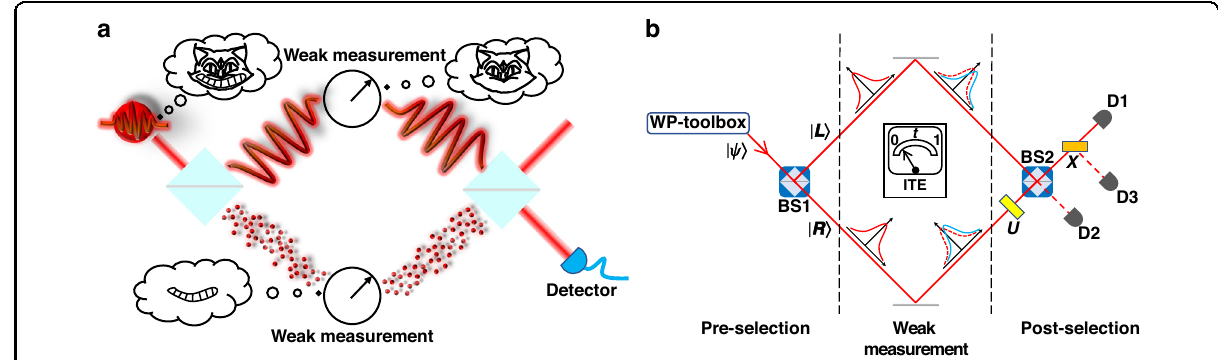
Fig. 1 Schematic for the separation of the wave and particle attributes, inspired by the quantum Cheshire cat concept. a Conceptual diagram. A cat (wave ‒ particle superposition state) enters the interferometer. By extracting weak values, it is surprising to fi nd that the cat (wave attribute) and its grin (particle attribute) have been separated spatially. b Theoretical scheme. The wave ‒ particle superposition state, ψ j i , obtained through the WP-toolbox passes the beam splitter (BS1) and is divided into the paths L j i and R j i , thus achieving the preparation of the pre-selection state, ψ i j i . Next, a weak measurement is implemented to simulate the ITE, which leads to wave packets of ψ i j i with a minimal shift. The post selection is composed of U , BS2, X and Detectors D1 – D3, which achieves the projection operation to the post-selection state, ψ f j